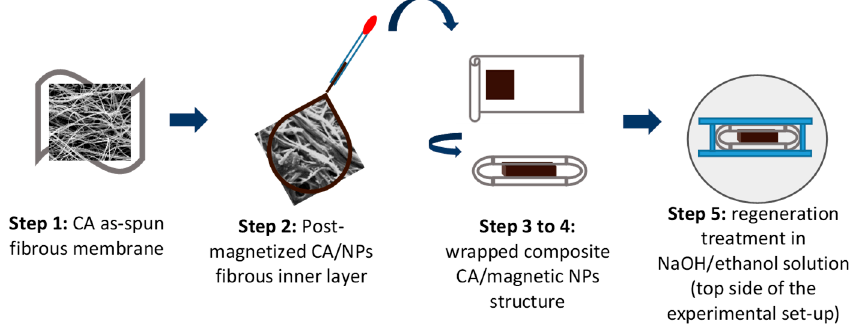
Figure 2. Schematic representation of the preparation steps followed for generating the composite CA / MIONP-OAOA _CA / CA sandwiched structure.